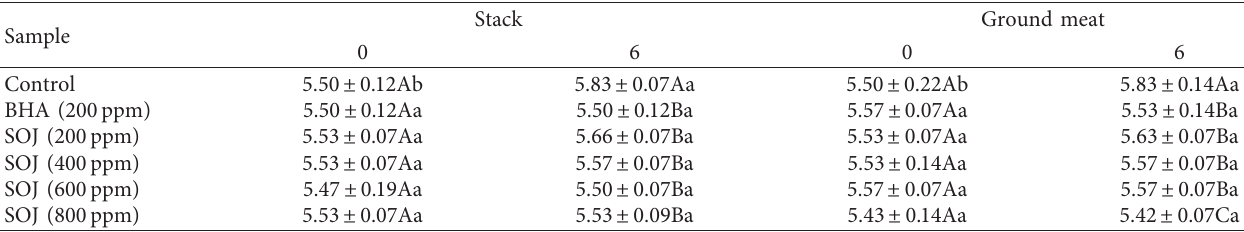
Table 4: pH of stacked and ground meat samples incorporated with Shahpouri Orange Juice (SOJ) and BHA during storage at 4 ° C for 6 days. Stack Ground meat Sample